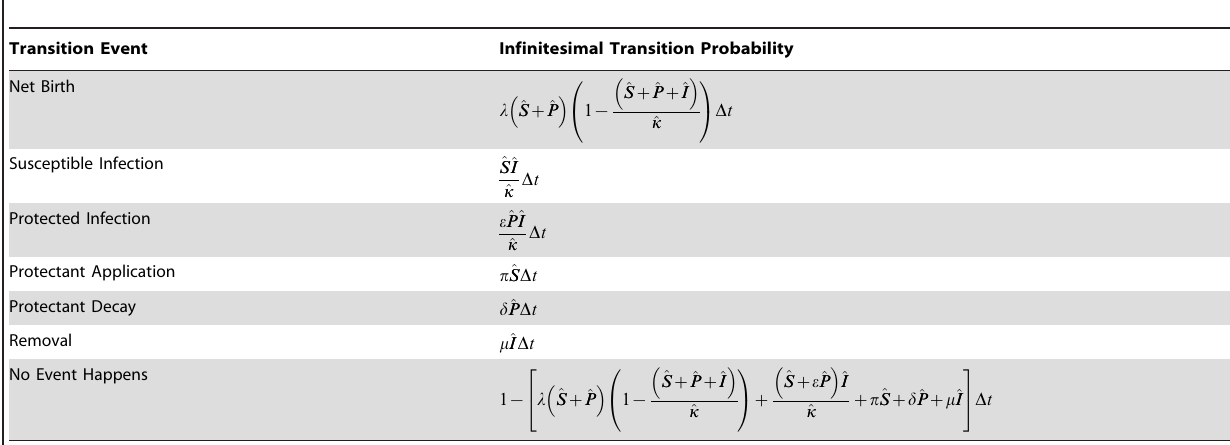
Table 3. Transition Probabilities. Infinitesimal transition probabilities for the stochastic Markov process version of the explicit model.